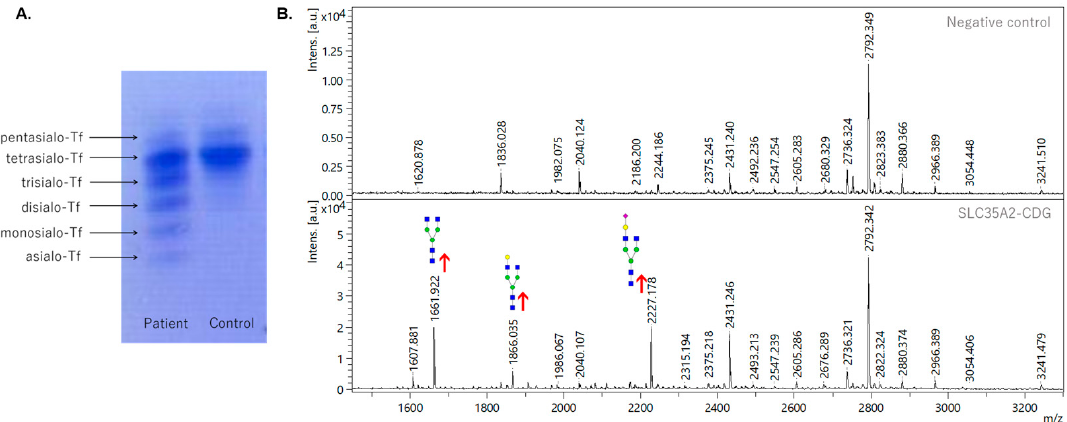
Figure 1. Analysis of glycosylation pattern of serum transferrin from control and SLC35A2-CDG patient samples. ( A ) Isoelectric focusing of serum transferrin. ( B ) MALDI-TOF analysis of permethylated N -glycans in sodiated form released from serum transferrin. Red arrows indicate increased intensities of respective N -glycan structures in the patient’s sample. Green circle—mannose, blue square— N -acetylglucosamine, red triangle—fucose, yellow circle—galactose, purple diamond—sialic